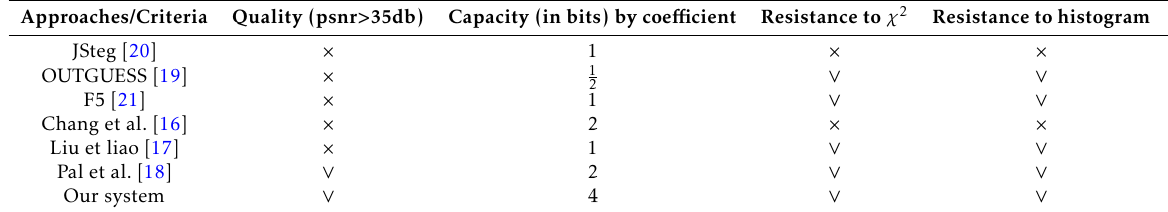
Table 4: Our approach vs. similar works in terms of robustness. ∨ = yes and × =